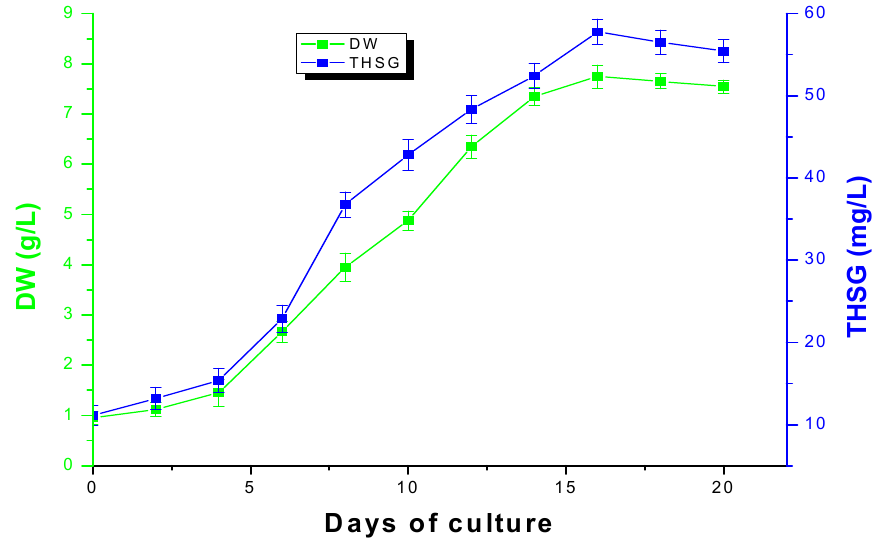
Figure 4. Time course of cells growth and THSG accumulation in MS medium. 2 g FW cells were inoculated into 60 mL MS medium in 250 mL shake flask on a rotary shaker (100 rpm). Vertical bar represents standard error of three